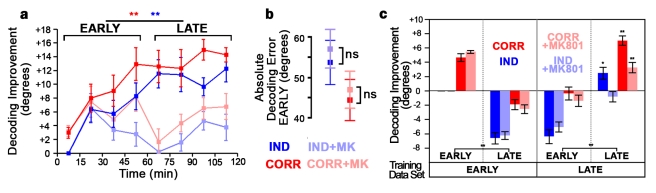
Training induces NMDAR-dependent improvement of whole-network encoding.(a) Time course of noise-correlation–based (red) and independent (blue) decoding performance. Light curves, improvement is blocked by MK-801. Bars denote early and late epochs. Decoding improvement is the decrease in decoding error relative to the independent decoder at the first timepoint. Both decoders improved from early to late epochs in control, but not MK-801–treated tadpoles (paired t-tests). (b) Decoding error of control (left, blue) and MK-801–treated (right, red) tadpoles over first hour of stimulation. Lighter shades denote decoding using the optimal independent decoder, darker shades mark noise correlation-based decoding. (c) Improvement, relative to the early epoch, of decoders trained on data from early (left two panels) or late (right two panels) epochs, used to decode early or late neuronal firing patterns. Performance decreased when decoding the epoch on which the decoder was not trained (center two panels; ANOVA). Asterisks in rightmost panel denote significant difference from corresponding value in leftmost panel. Error bars denote SEM. *p<0.05; **p<0.01.